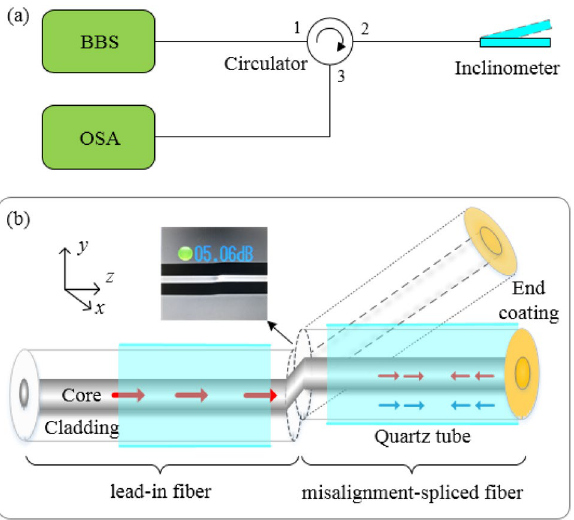
Figure 1. ( a ) Schematic diagram of the experimental setup. ( b ) Schematic diagram of the